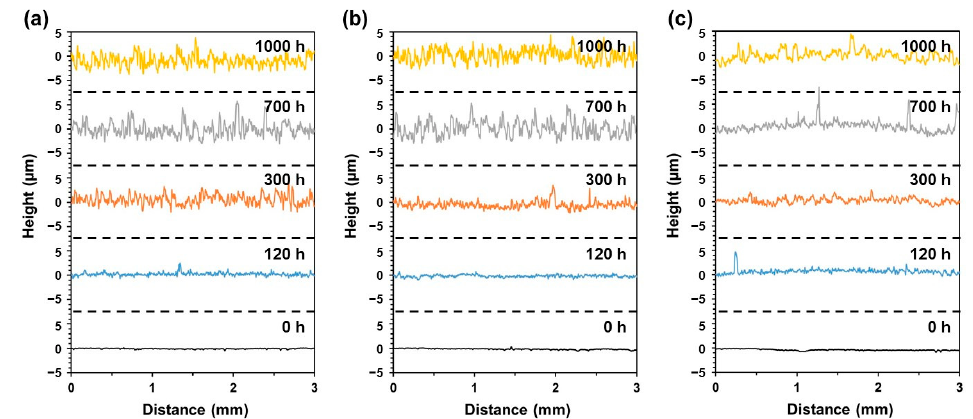
Figure 7. Representative surface topographic profiles of the oxide scales, obtained from contact profilometer, formed on the ( a ) SS301, ( b ) DS2205 and ( c ) DS2507 after exposing to molten salts for different times.